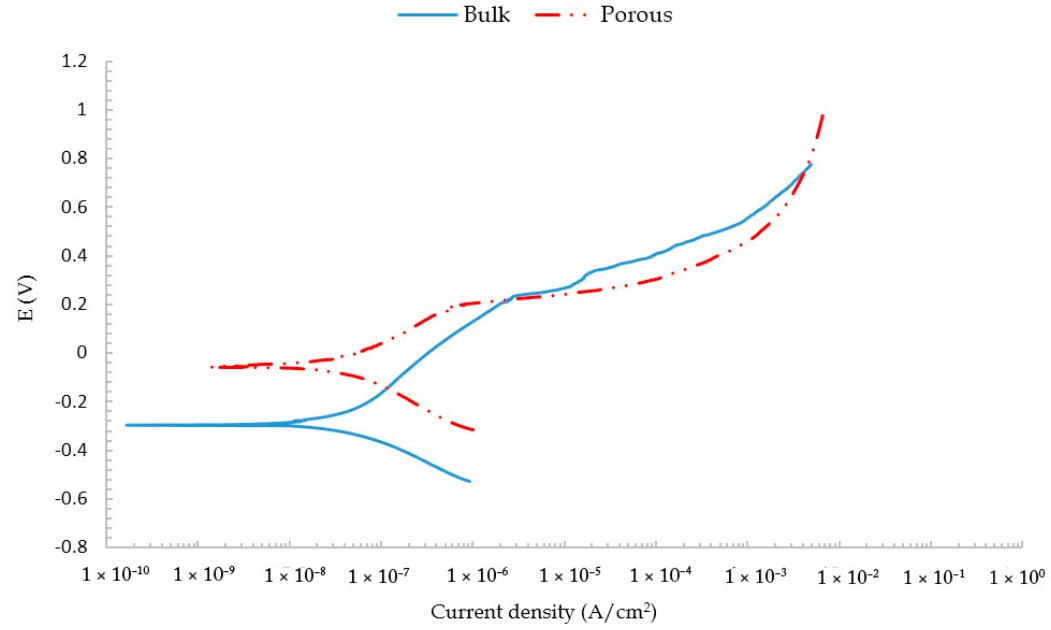
Figure 6. The potentiodynamic polarization curves of the AM NiTi alloys with two different structures; bulk and 30% porous structure.